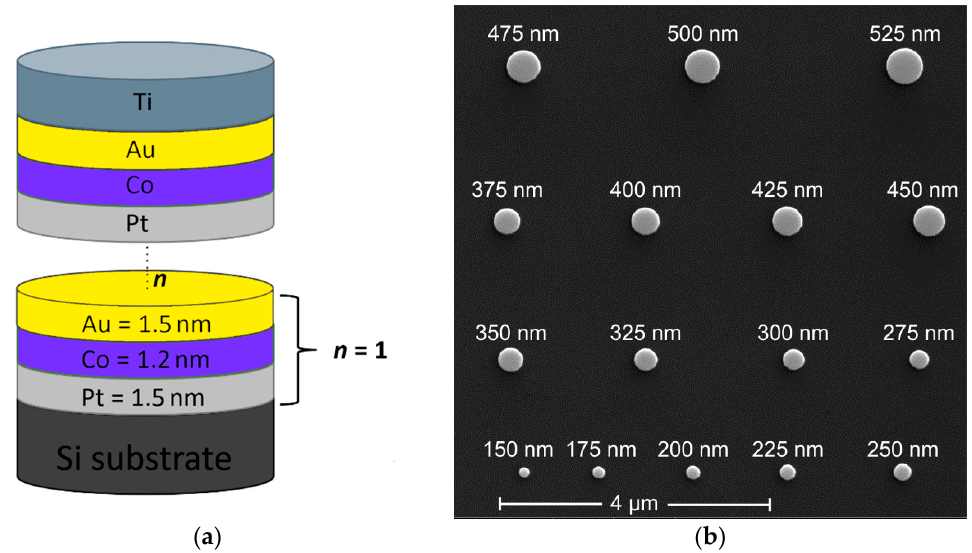
Figure 1. ( a ) Schematic representation of multilayer nanodot based on ultrathin Co layers placed between two different heavy metals (Au, Pt), where n represents the number of trilayer Au/Co/Pt unit-cell repeats. The value of n ranges from 4 to 7. ( b ) Scanning electron microscope top view of an array of multilayer dots patterned by the electron-beam lithography and etching method. The 16 nanodots have diameters in the range of 150–525 nm with the step of 25